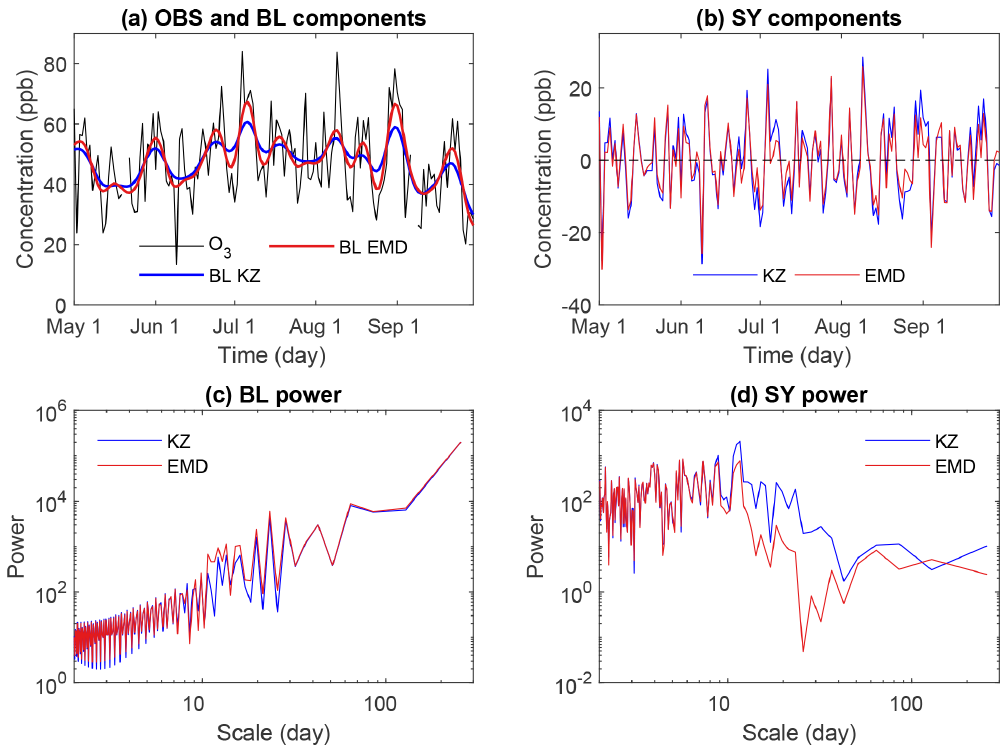
Figure 2. (a) Raw observed (OBS) DM8HR ozone time series (black) and the embedded baseline (BL; red for EMD and blue for KZ) at Altoona, PA, in 2010. (b) Time series of synoptic (SY) forcing (red for EMD and blue for KZ). Panels (c) and (d) show their corresponding power spectra. Panels (c) and (d) compare the power spectra of the baseline forcing (c) and the synoptic forcing (d) derived from KZ filtering and EMD (sum of IMF1 and IMF2). Notice that most of the energy in the baseline time series is in the longer timescale, while most of the energy of the short-term component is in the high-frequency range. The similarity of results from both scale separation techniques demonstrates that the two scales of interest (i.e., baseline and synoptic forcing) have been extracted reasonably well by these two methods.